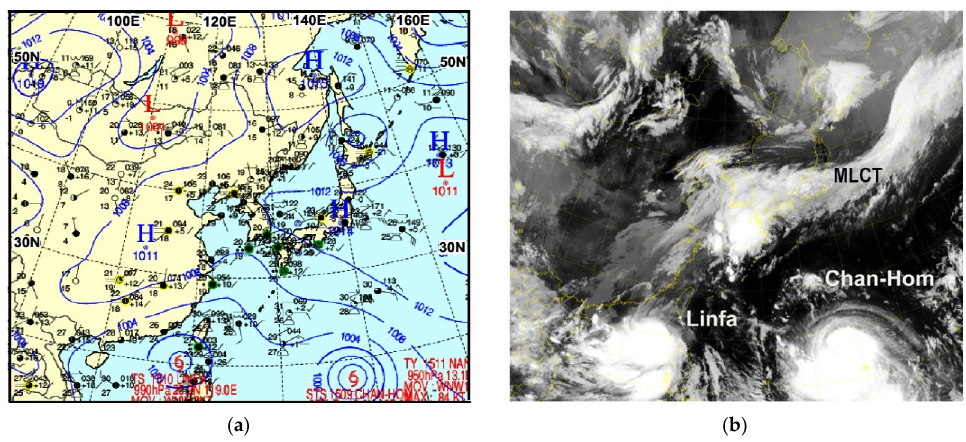
Figure 12. As shown in Figure 3, except for ( a ) surface pressure analysis (hPa), and ( b ) COMS-IR. satellite image at 09:00 LST 7 July. TS Linfa entering the northern part of the South China Sea increasingly interacted with TY Chan-Hom and the MLCT, as their distance decreased.